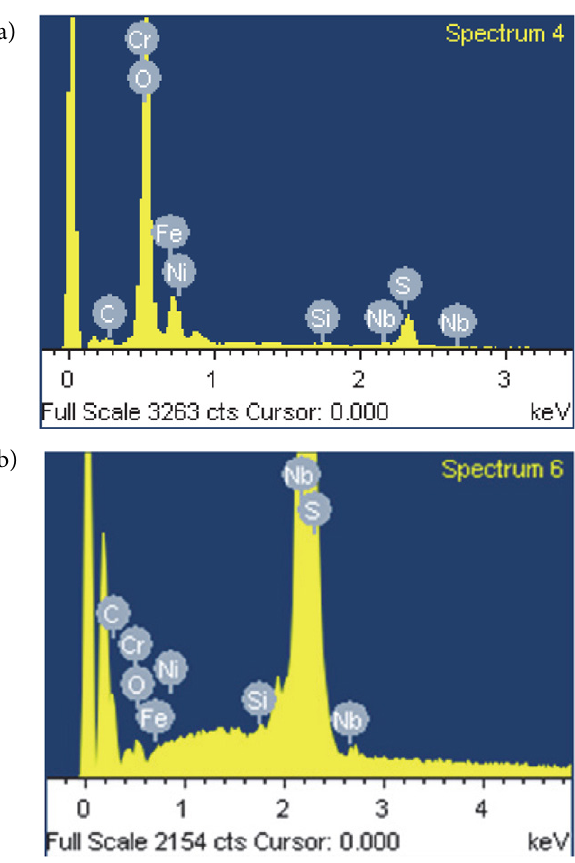
Figure 2. EDS results for AISI 347 from Figure 1a): a) white precip- itants and b) dark